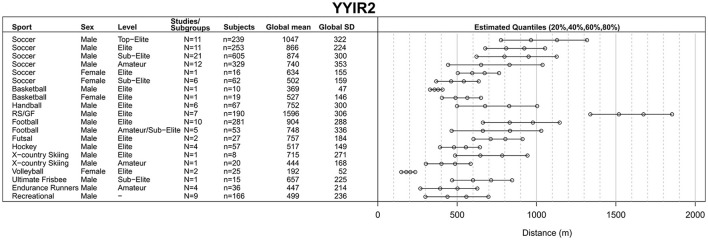
Yo-Yo Intermittent Recovery Level 2 (YYIR2) test results. RS, Rugby sevens; GF, Gaelic football.